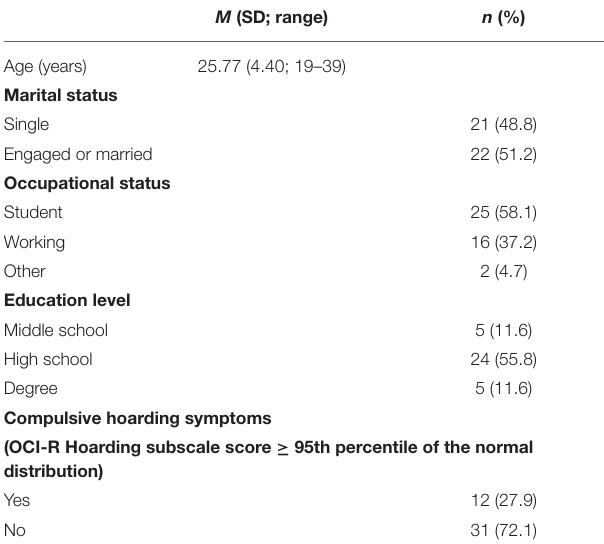
TABLE 1 | Demographic characteristics of participants ( n =